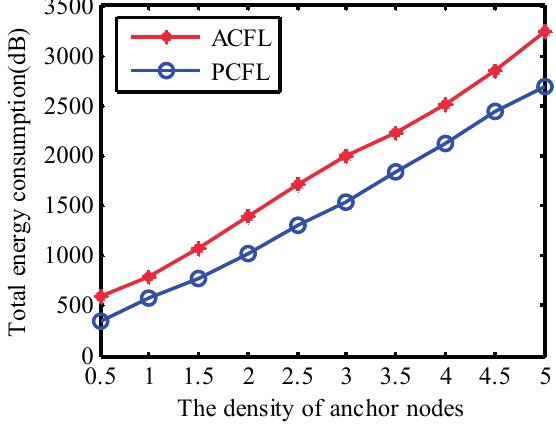
Figure 9. Total energy